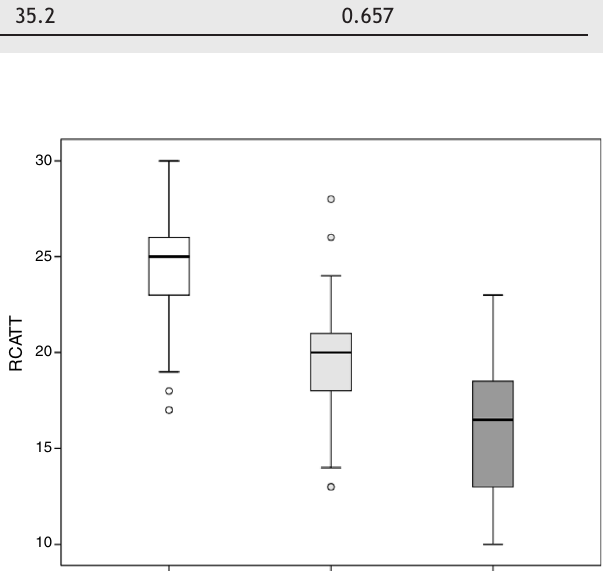
Figure 4 Total score values of Rhinitis Control Assessment Test (RCAT) discriminated by the severity of nasal symptoms as mild (white), moderate (light gray), and severe (dark